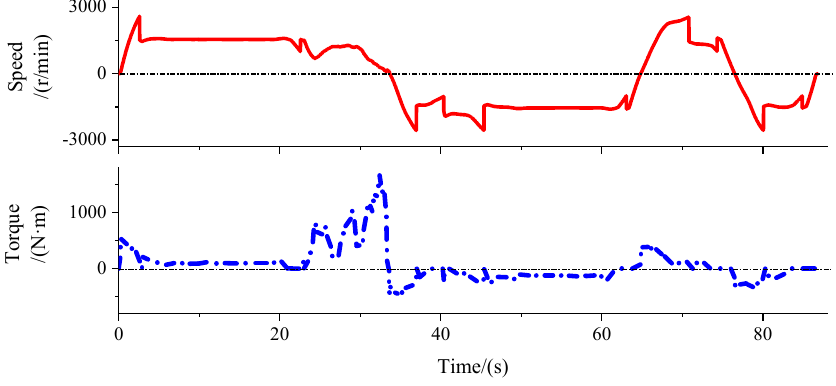
Figure 21. The simulation results of the electric motor.